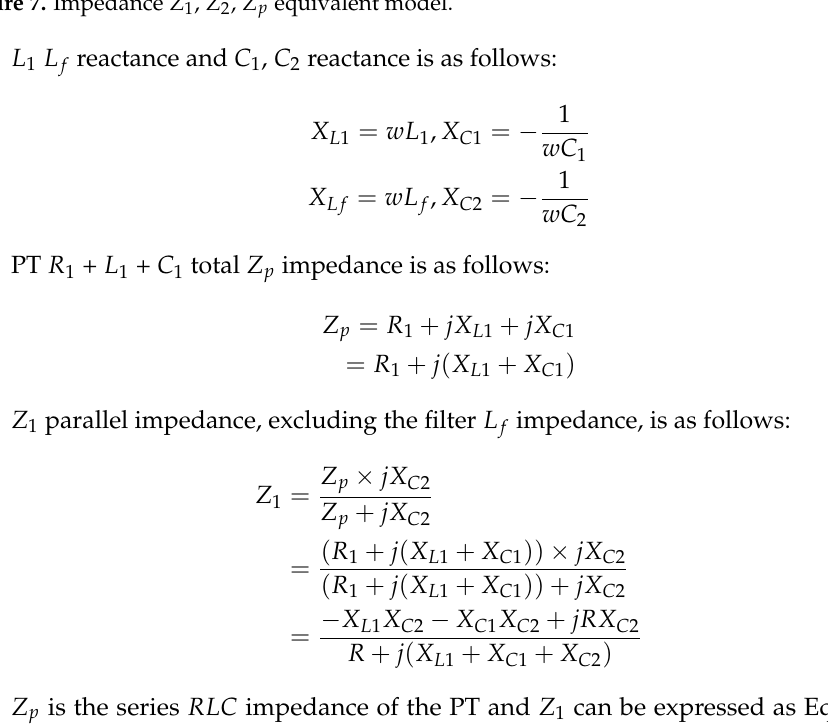
Figure 7. Impedance Z 1 , Z 2 , Z p equivalent